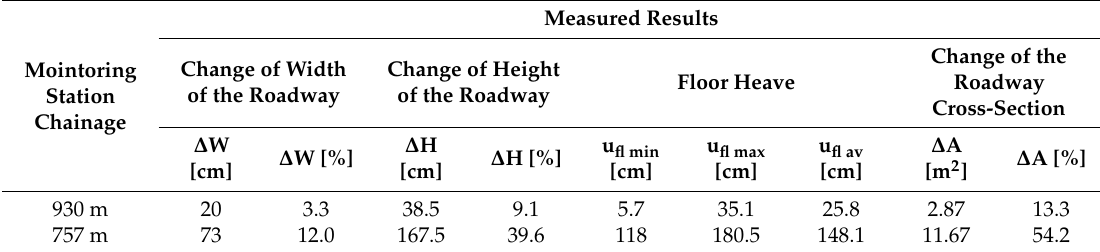
Figure 4. Maingate D-2 convergence—station at chainage 757 m ( Δ W—roadway width change, Δ H—roadway height change, u rf —roof displacement, u fl —floor heaving). Table 2. Results of convergence measurements in Maingate D-2 [10].